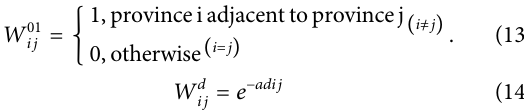
Frontiers in Environmental Science |